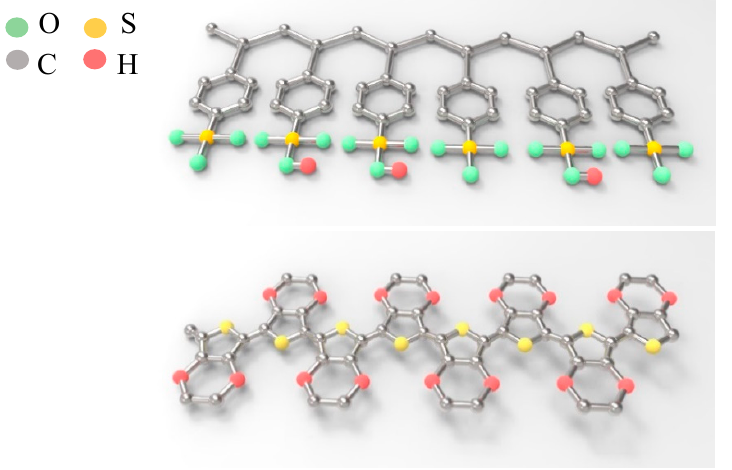
Figure 5. Schematic molecular structure of PEDOT:PSS.